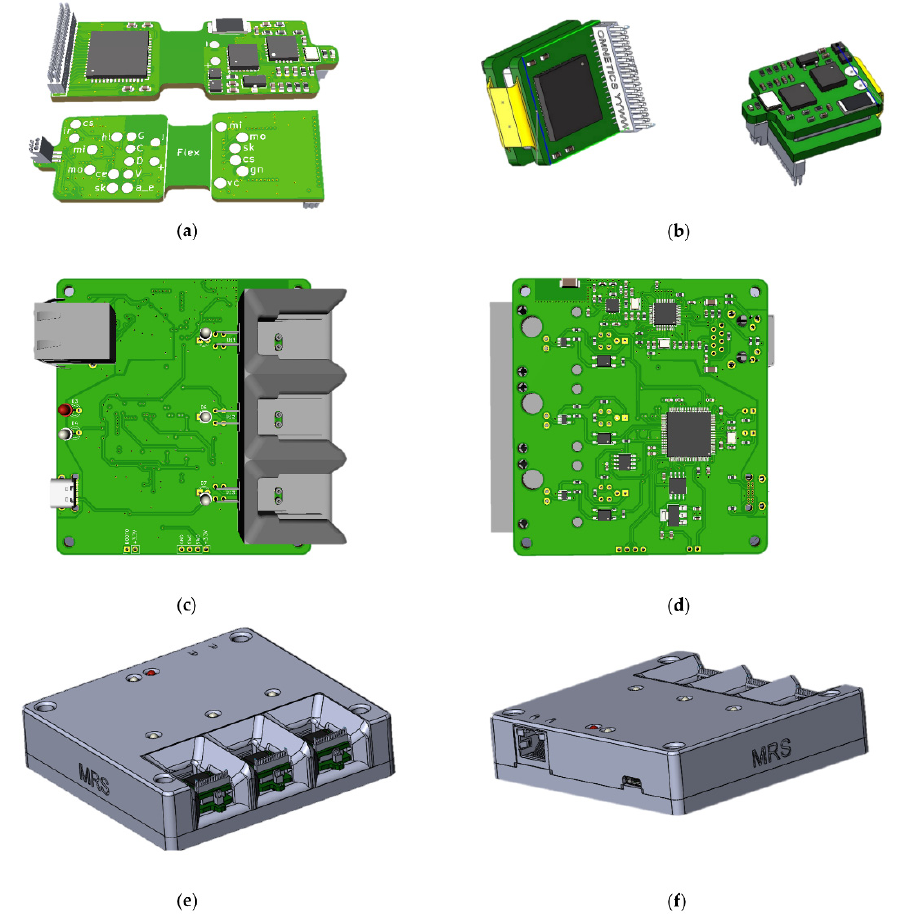
Figure 1. Printed circuit boards of wireless module: ( a ) top view and bottom view, ( b ) folded and base station: ( c ) top view, ( d ) bottom view; 3d model of base station: ( e ) front sides, ( f ) back sides, housing.